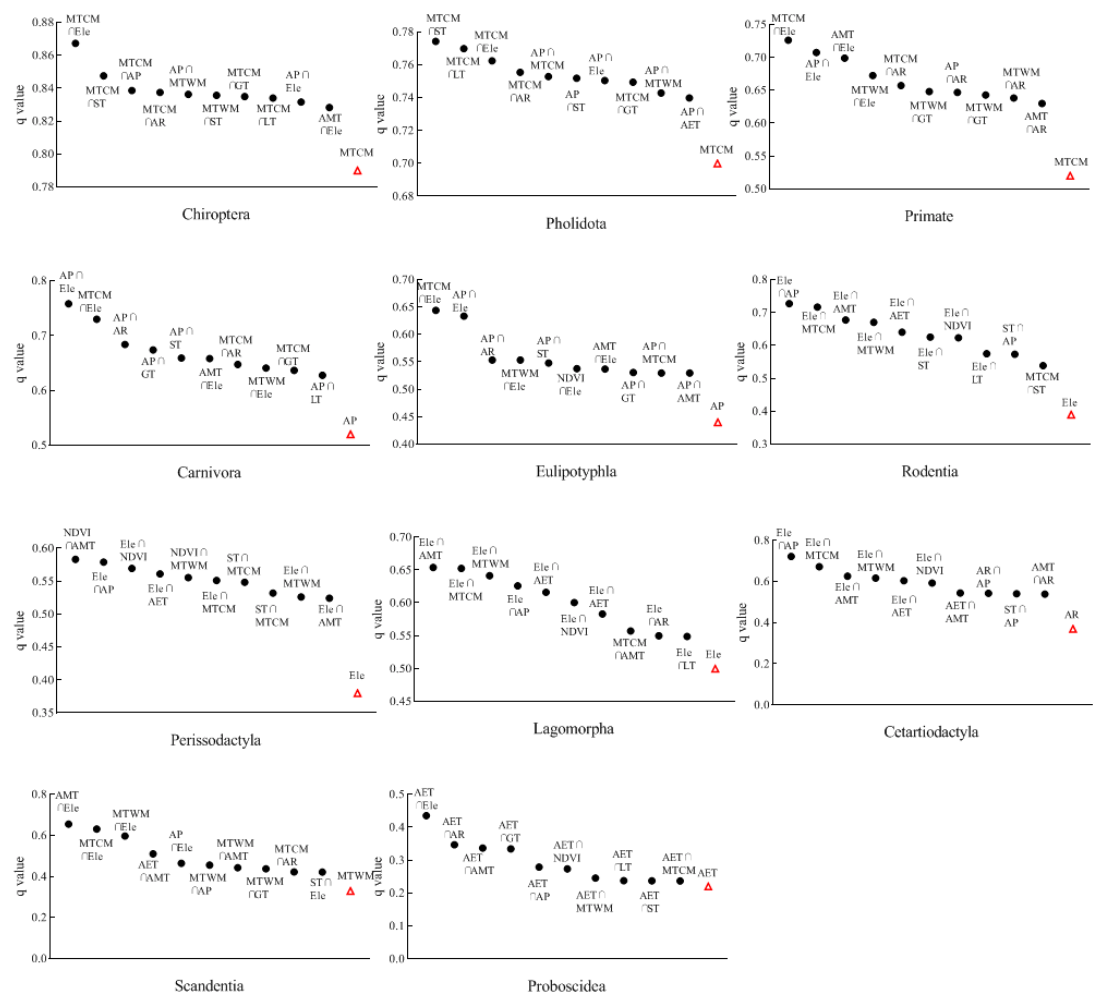
Figure 5. Interaction factors and single factors mainly affecting the species richness of each order. In areas where the annual precipitation was 897.83–1146.46 mm, species richness was the most abundant. However, below the level of 305.96–480.55 mm of the AP, less precipi- tation was not conducive to the aggregation of many species. For the terrestrial mammal richness, most of the species richness was in the AMT range of 20.28–28.23 ◦ C (Figure 6). However, when the annual mean temperature was below zero, the species richness was low. The species richness was most abundant in the range 13.28–23.65 ◦ C of MTWM and the range 6.39–17.64 ◦ C of MTCM. Extremely low ambient temperatures had negative impacts on the distribution of animals. In areas where the actual evapotranspiration was large, the species richness was high. A higher vegetation index denoted a higher species richness. Mammalian species richness was the most abundant in forest land, with some mammals mainly distributed in shrub wood. However, the species richness was low on unused land, including bare areas, where land is difficult to be used. Terrestrial mammals were mainly distributed in areas with ferralsols. These soils were mainly distributed in humid tropical and subtropical regions. At the elevation range of 1905.60–2562.62 m, species richness was greatest but then decreased with increasing altitude. Species richness was abundant at 2613–3816 m of altitude relief, but richness declined when altitude relief was too flat. There was a high level of species richness in the extremely undulating mountains, and there were significant differences among the landform